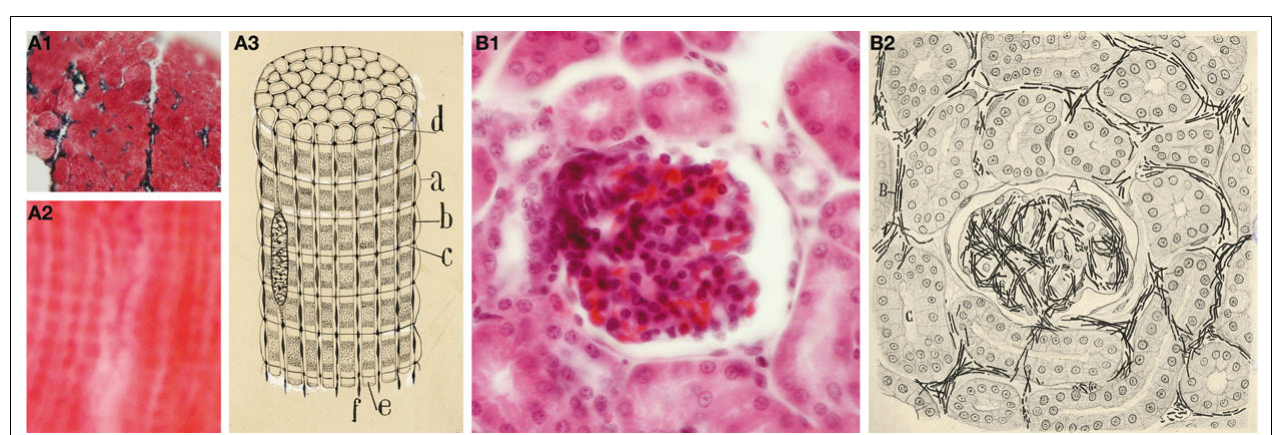
of the gut, (methylene blue method); (C) Intravillous plexus of the gut (Golgi method); (D) Meissner ganglion (Golgi method); (E) Ganglionic cell (Nissl) (Drawings reproduced with the permission of Inheritors of Santiago Ramón y Cajal ©).